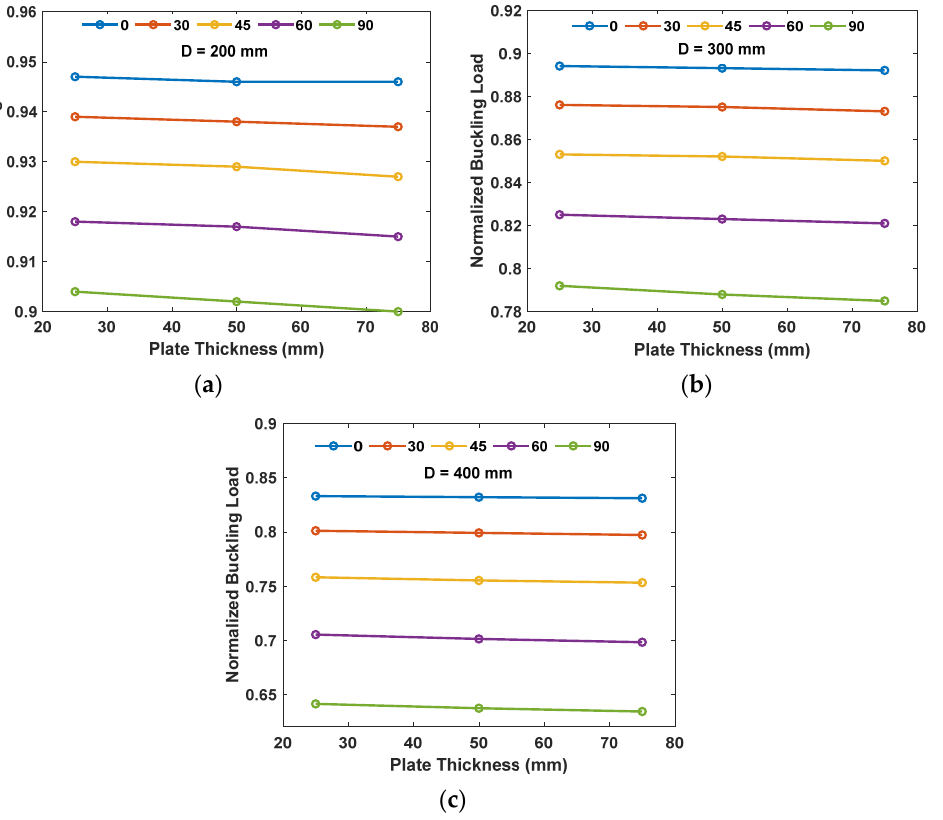
Figure 3 . The variation of the cutout arrangements on the normalized buckling load for ( a ) D = 200 Figure 3. The variation of the cutout arrangements on the normalized buckling load for mm, ( b ) D = 300 mm, and ( c ) D = 400 mm with various plate thickness. ( a ) D = 200 mm, ( b ) D = 300 mm, and ( c ) D = 400 mm with various plate